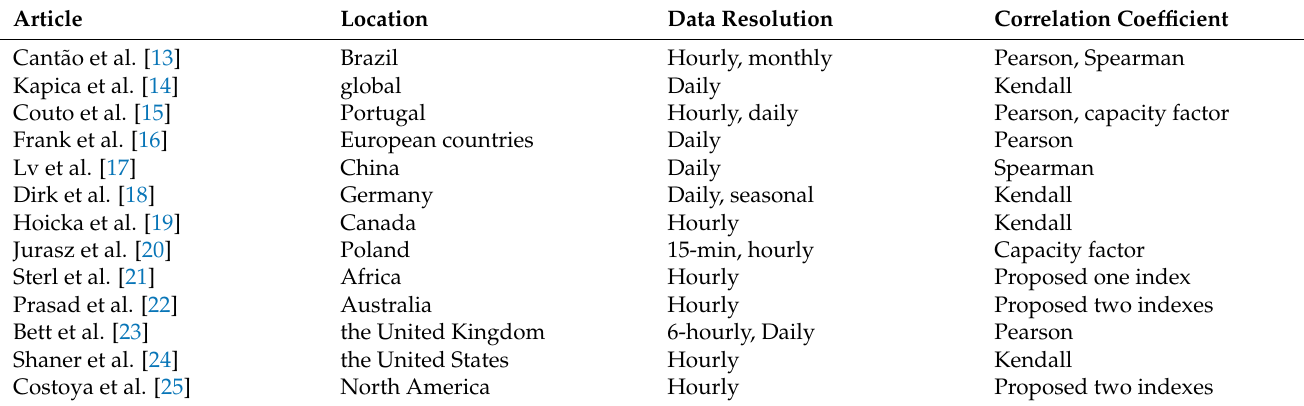
Table 1. Details of complementary